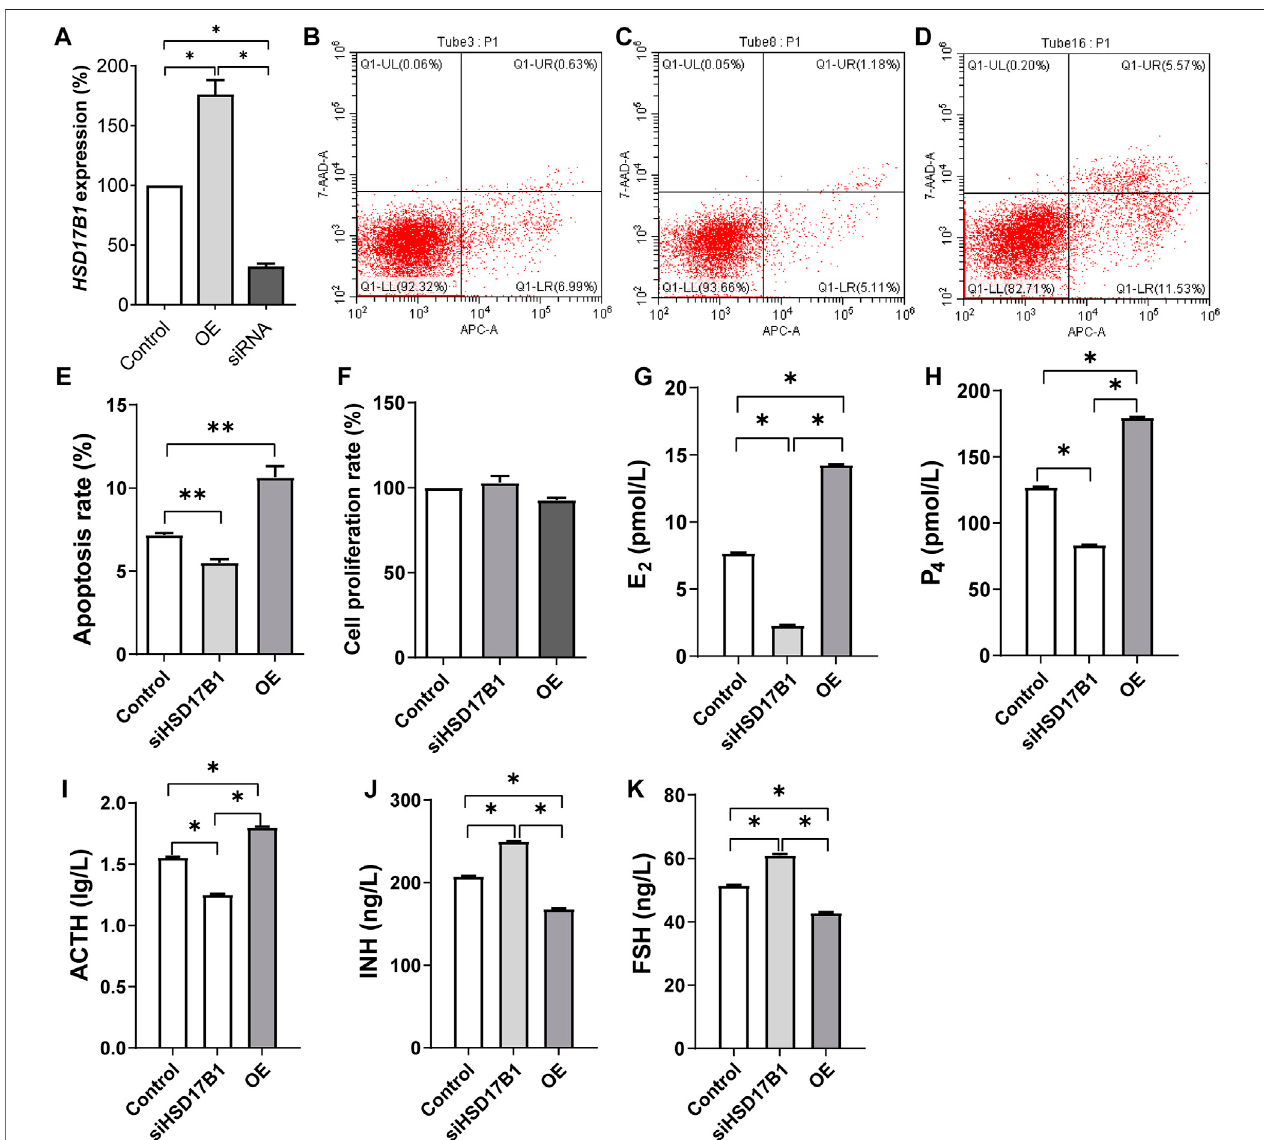
FIGURE5| Functionalveri fi cationofHSD17B1geneingranulosacells.E2,estradiol;P4,progesterone;ACTH,adrenocorticotropichormone;INH,inhibin-B;FSH, follicle-stimulating hormone; OE, overexpression. * p < 0.05; ** p < 0.01. The data are expressed as mean ± SD. (A) Relative expression of HSD17B1 in granulosa cells after over expression and interference treatment. (B – D) The results of fl ow cytometry apoptosis in control, siRNA interference group and overexpression group, respectively. (E , F) showthestatisticalresultsofapoptosisrateandcellproliferationrate,respectively. (G – K) ThelevelofE2,P4,ACTH,INH,andFSH,respectively. Mult, Small Tail Han sheep (multiple births), n (cid:1) 3; Sgl, Xinji Fine Wool sheep (singleton), n (cid:1)